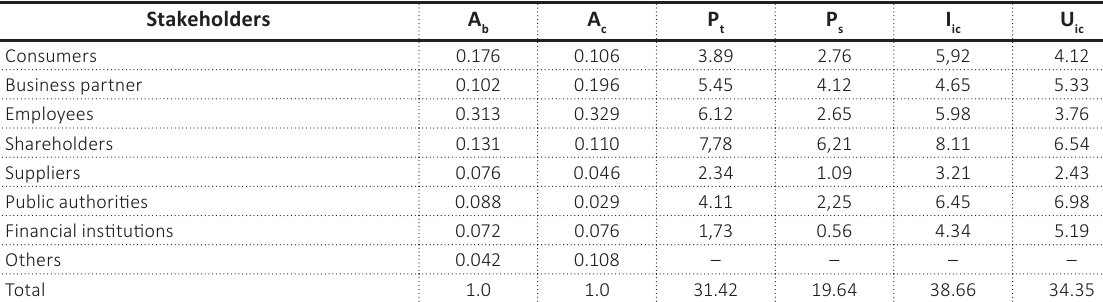
Table 2. Primary expert-analytical assessments of stakeholder ranking of PJSC KhTP